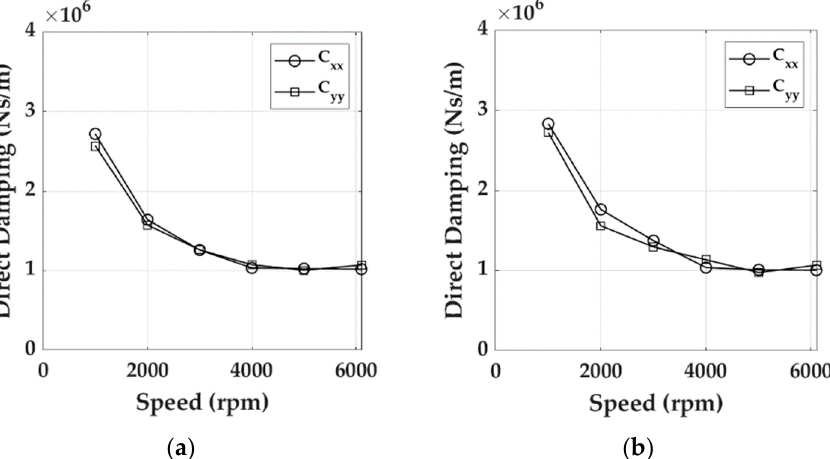
Figure 37. Flooded Ball & Socket Pivot bearing synchronous direct damping: ( a ) 1.0 MPa, ( b ) 1.7 MPa.